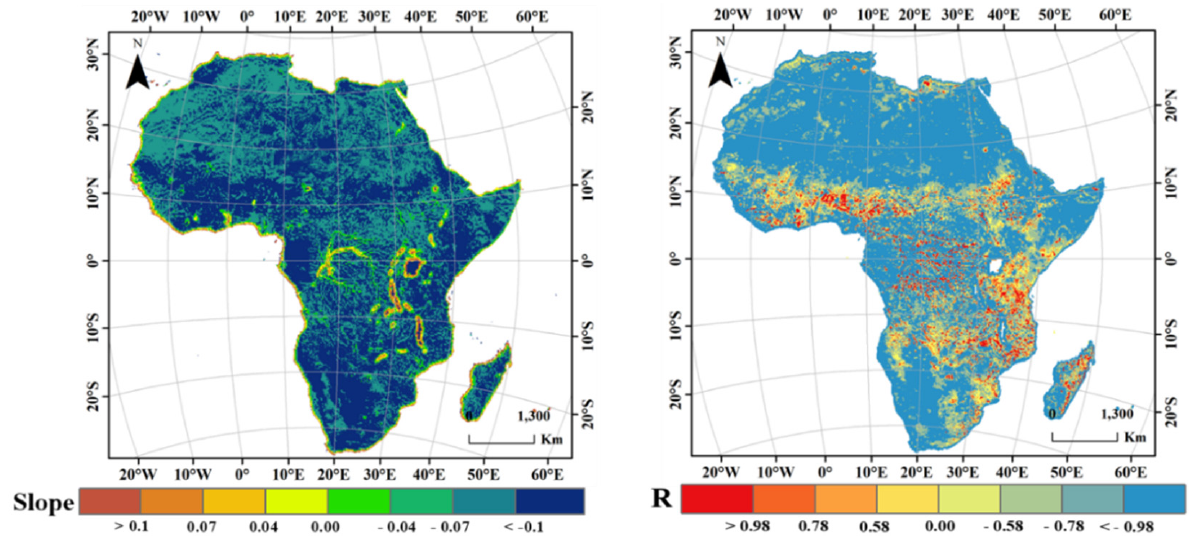
Figure 6. Interannual variability rates (slope, left ) and correlation coefficients (R, right ) of soil moisture from 2003 to 2017.